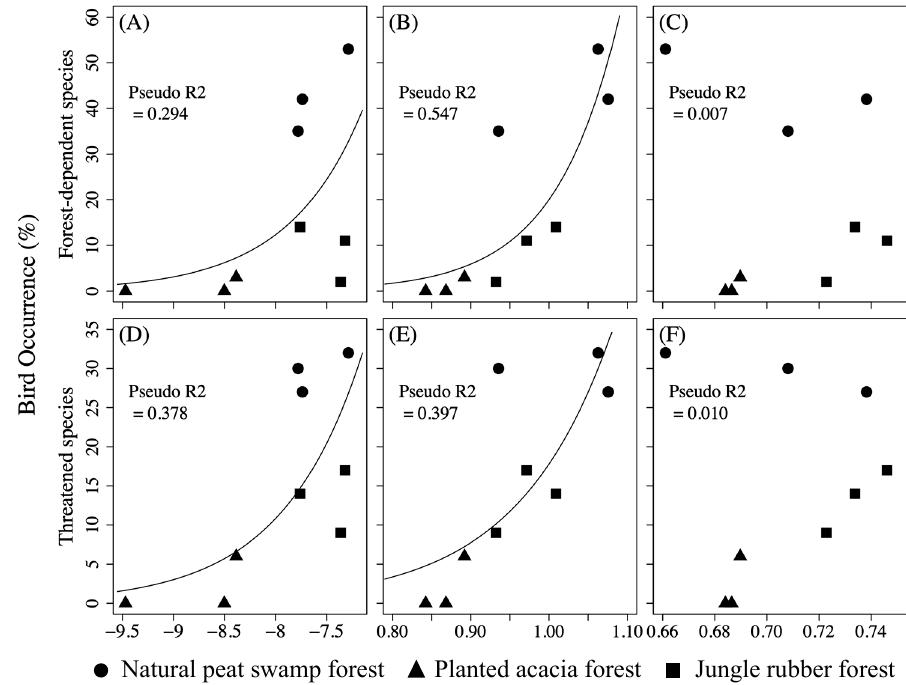
Figure 6. Bird occurrence rate (response variable) in relation to L-band polarimetric parameters (explanatory variable) for forest-dependent and threatened species. Solid line indicates logarithmic regression line: ( A – C ) forest dependent species with the explanatory variable of σ 0 VV, VV/HH, and